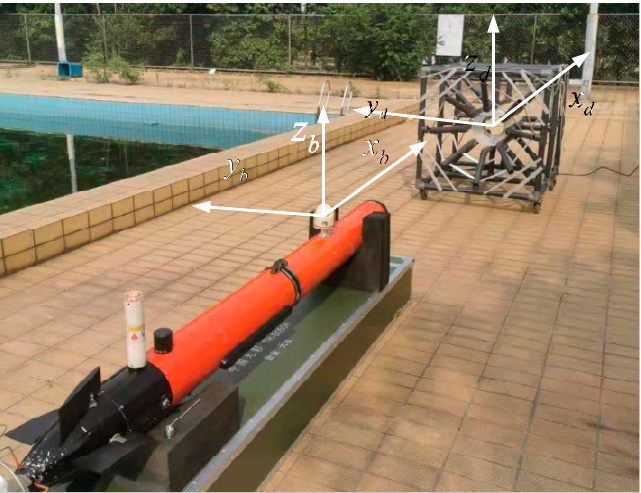
Figure 6. The fixed coordinates ( o − x d y d z d ) and body coordinates ( o − x b y b z b ) defined in AUV terminal docking.